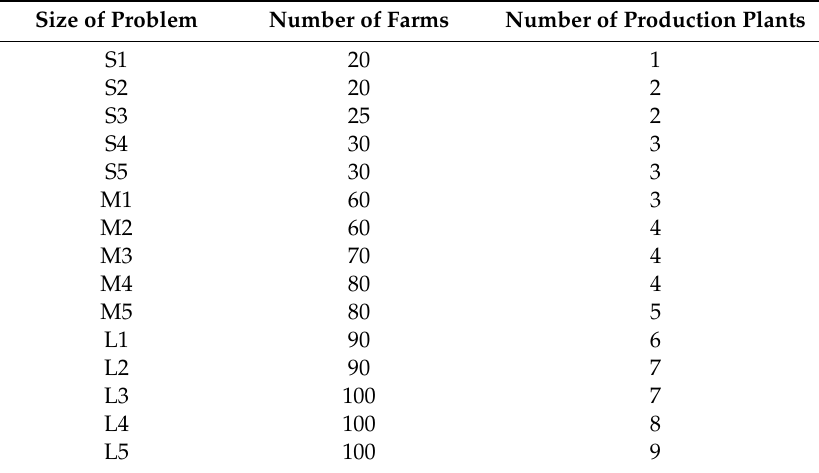
Table 2. Details of the test